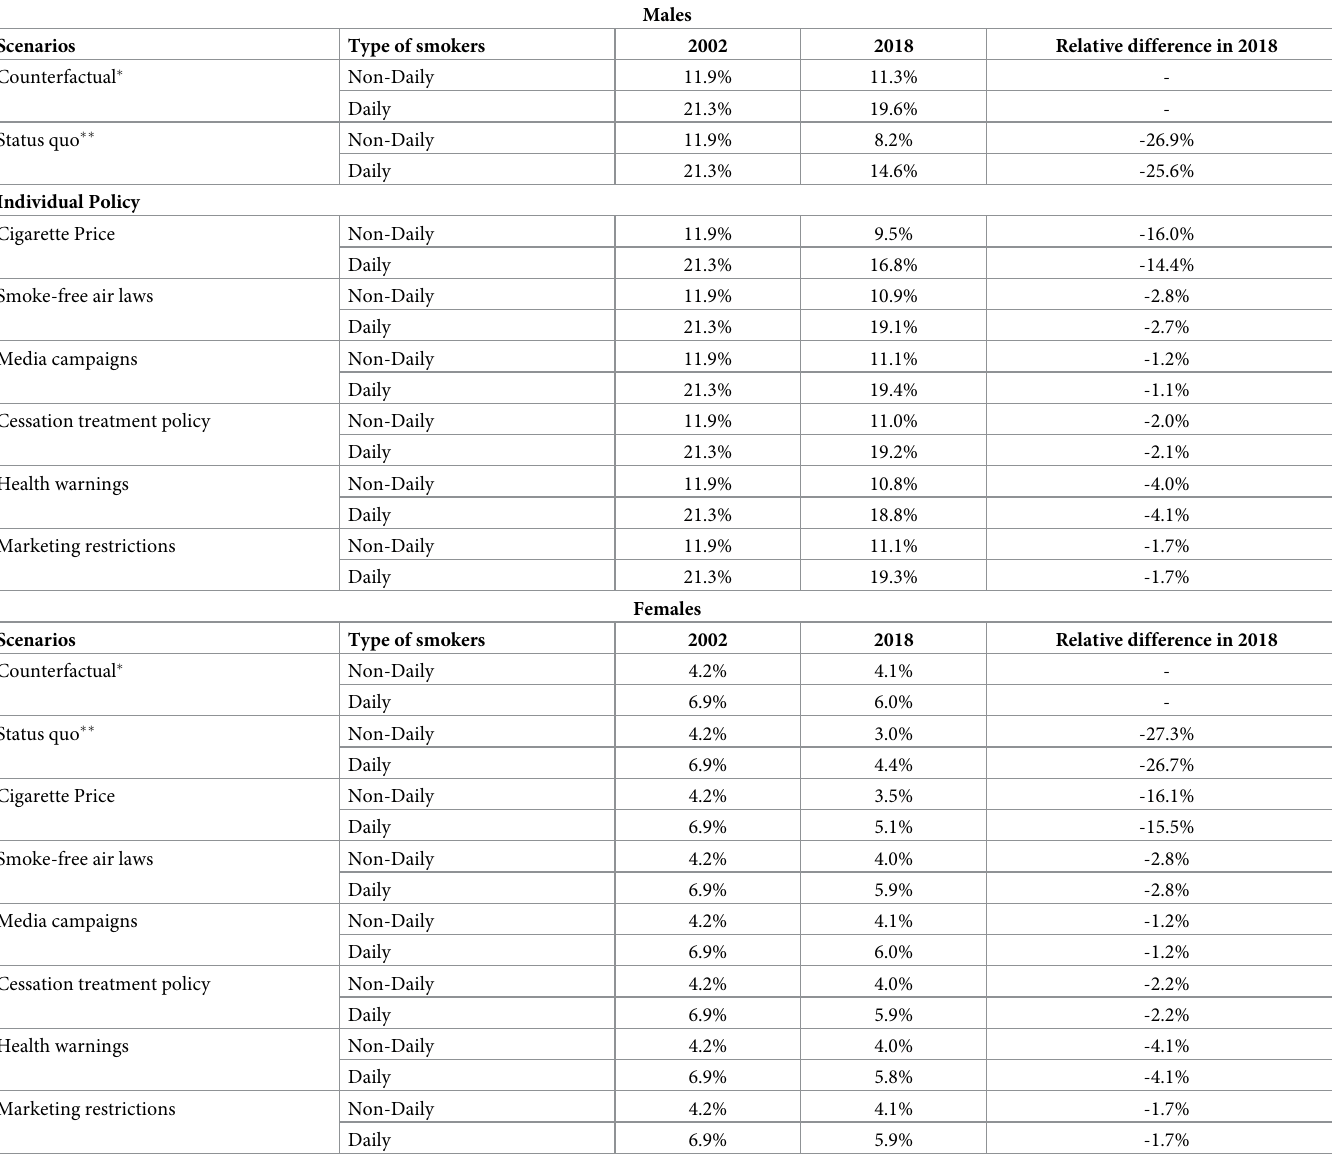
Table 2. Current smoking prevalence by smoking status and gender, from Mexico SimSmoke under different policy scenarios,